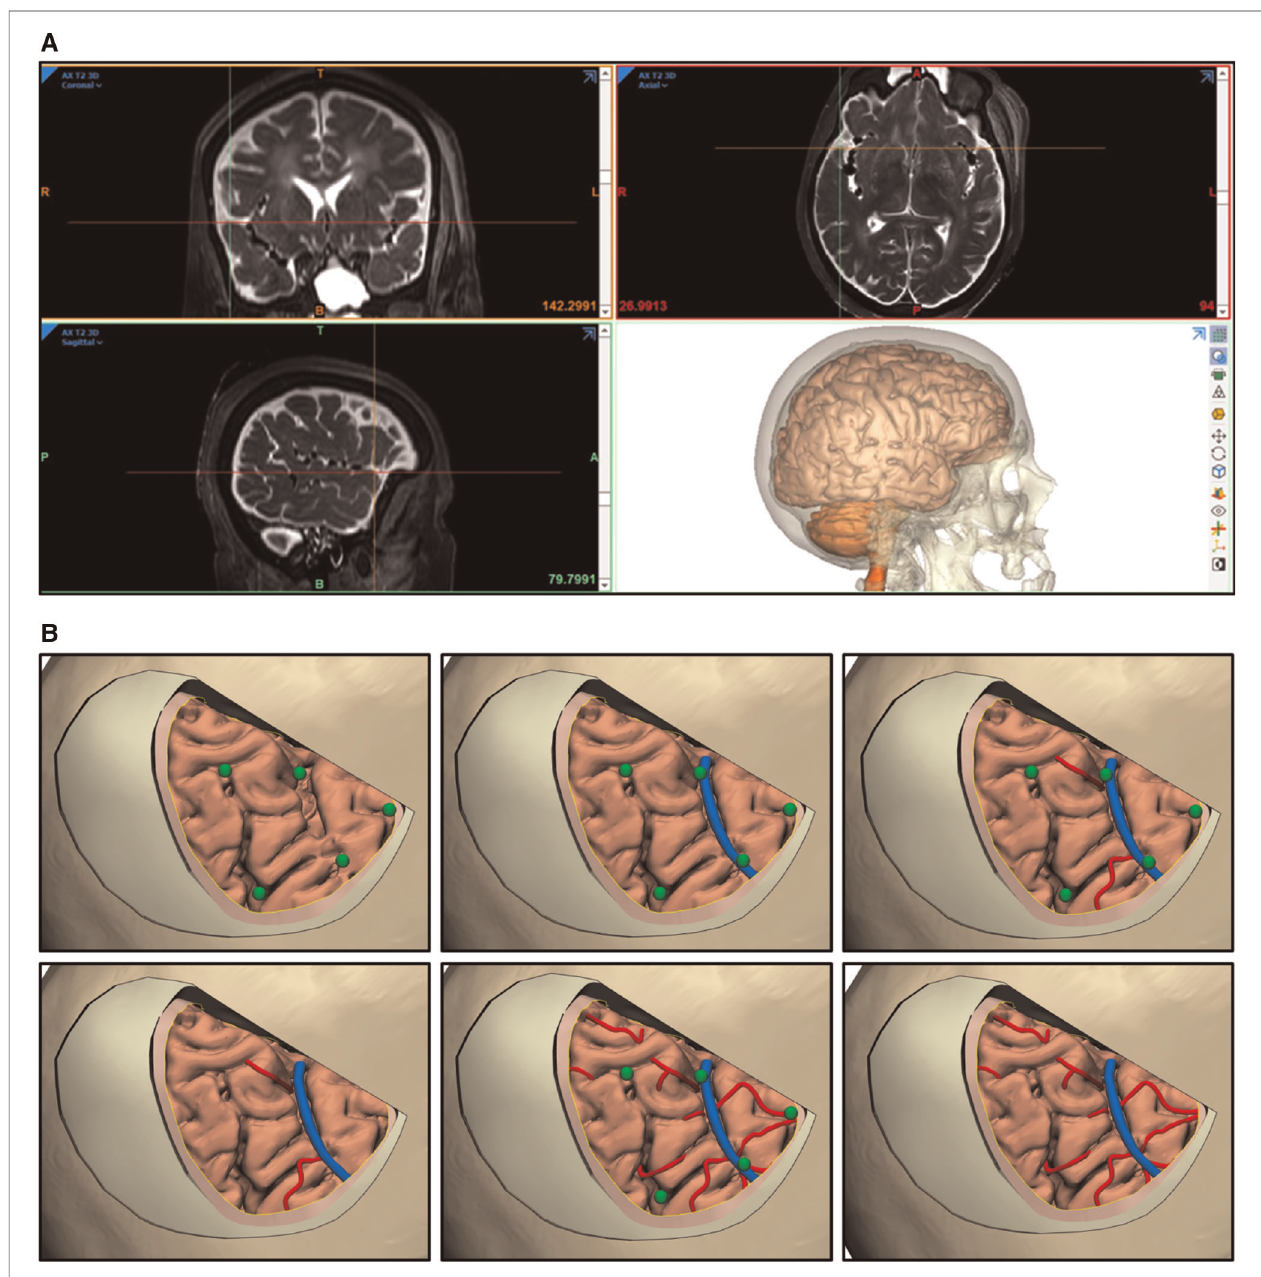
FIGURE 5 | Adding vasculature to 3D virtual models. ( A ) Vascular structures are visible on MRI (coronal, top left; axial, top right; sagittal, bottom left). However, the delineation of vascular structures in 3D models (bottom right) is not practical or accurate unless a contrast medium is used before the vessels are injected. ( B ) An alternative method is to arti fi cially add or draw arteries ( red lines ) or veins ( blue lines ) using certain anatomical landmarks acquired via neuronavigation and photography ( green dots ). Used with permission from Barrow Neurological Institute, Phoenix, Arizona